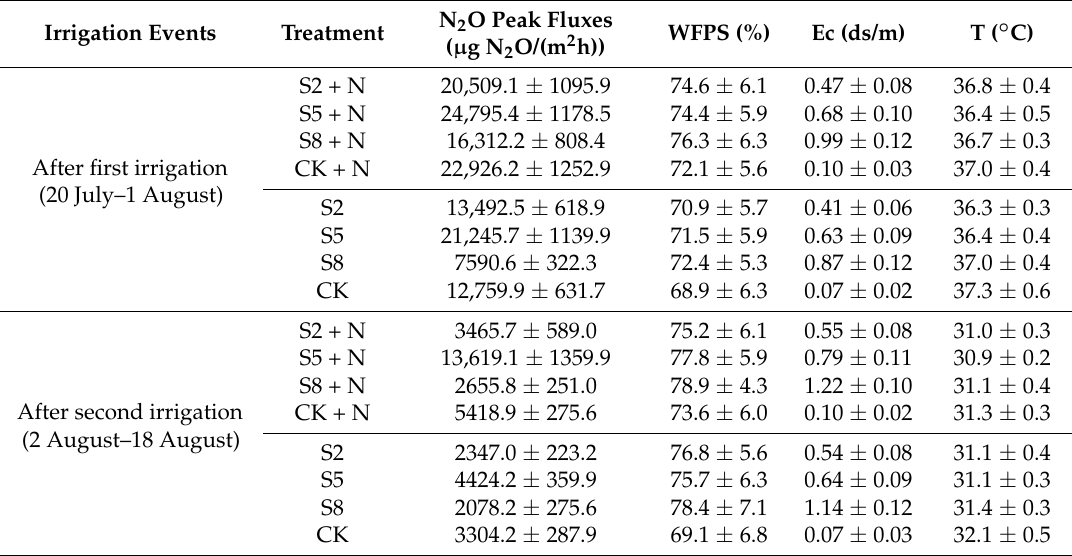
Table 4. Pulse N 2 O flux and its corresponding soil WFPS, Ec, and temperature. Irrigation